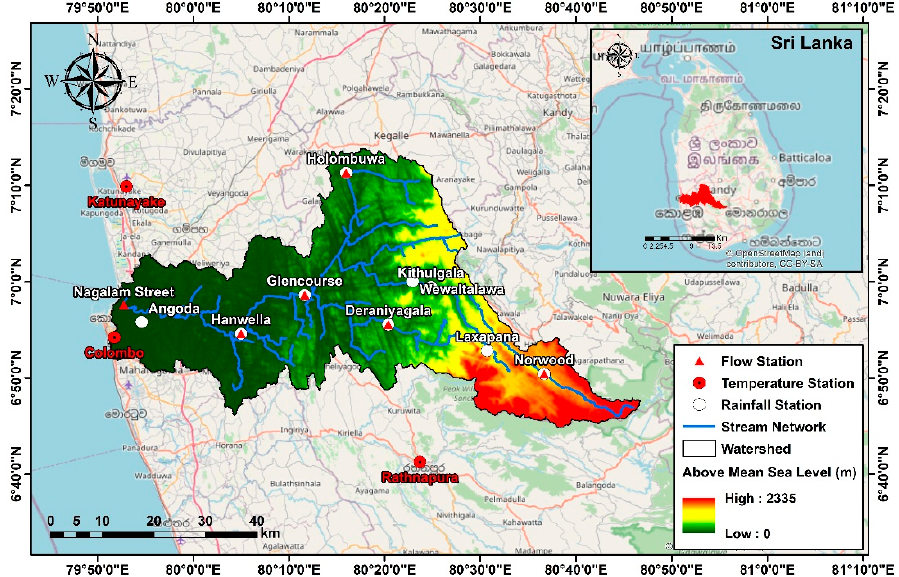
Figure 1. Kelani River Basin and hydro metrological station distribution.